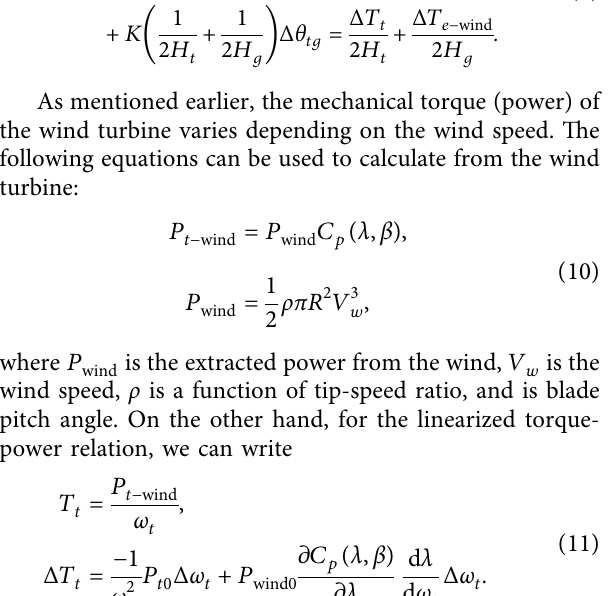
Figure 2: Drive train